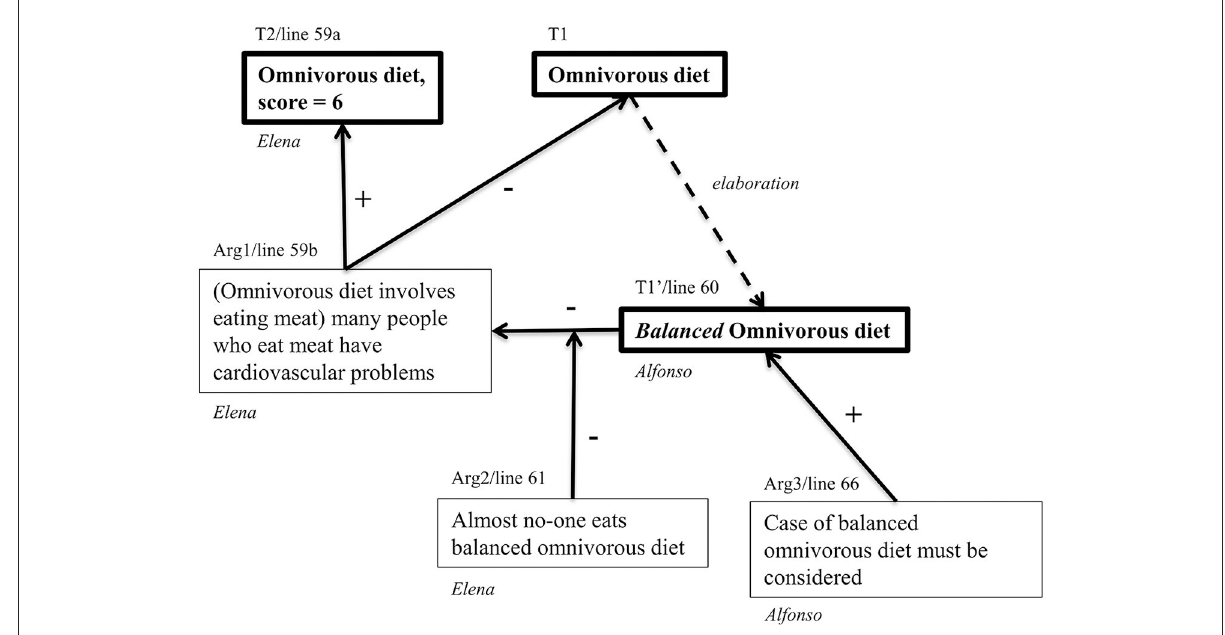
FIGURE4 Argument diagram of turns 59–72. Boxes with thick lines are claims, that become theses (T1, T2) once argued; boxes with simple lines are (counter-) arguments; “ + ” and “–” are arguments for or against; dotted arrows represent elaborations of theses, noted T ′